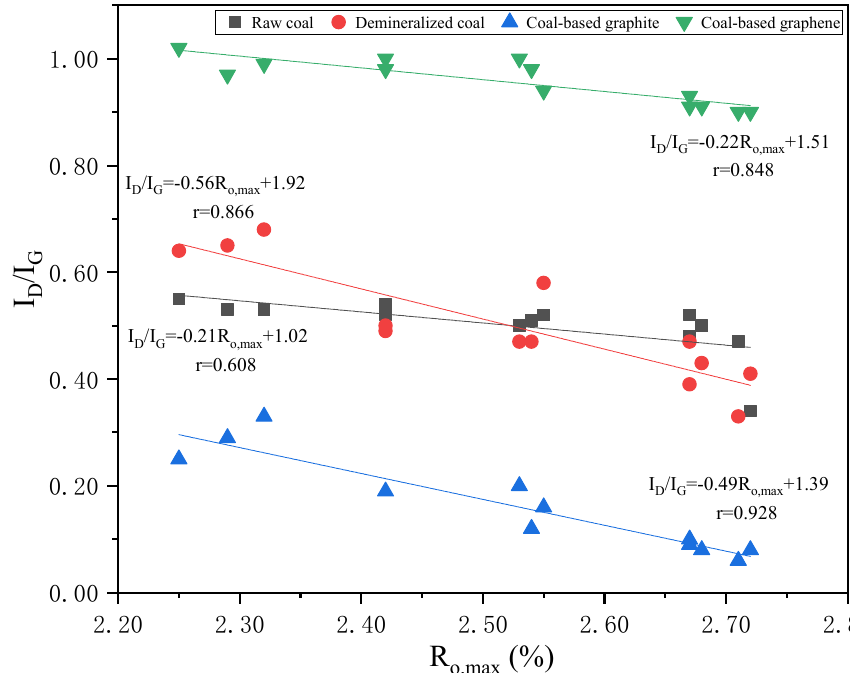
Figure 9. Scatter diagram of FWHM-G.